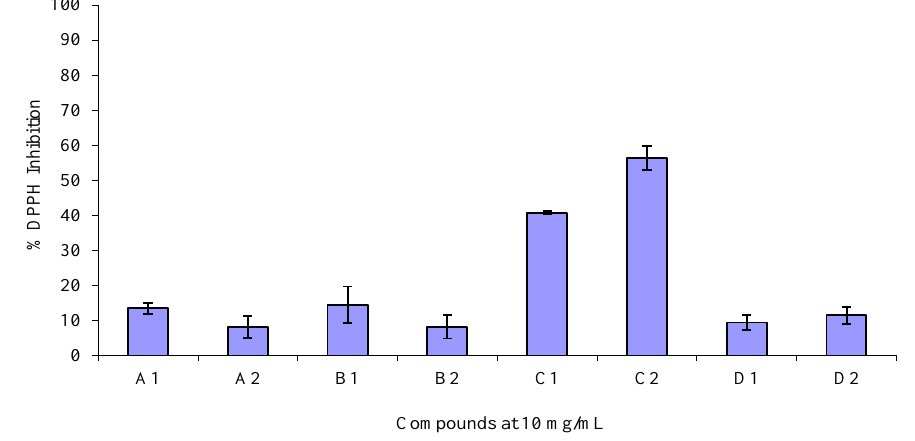
Figure 1. DPPH• radical scavenging activity for 3-carboxycoumarin derivatives at a 10 mg/mL concentration reported as percent of inhibition of